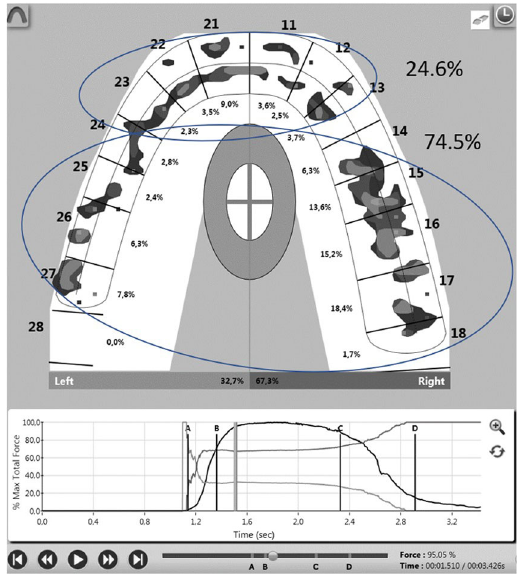
Fig. 3 The same T-Scan recording as in the Fig. 2. at t95. The force/time graph, the mFpr and the time elapsed are also displayed. The bite force is 95.05% mFpr. The ANT/BAT ratio is